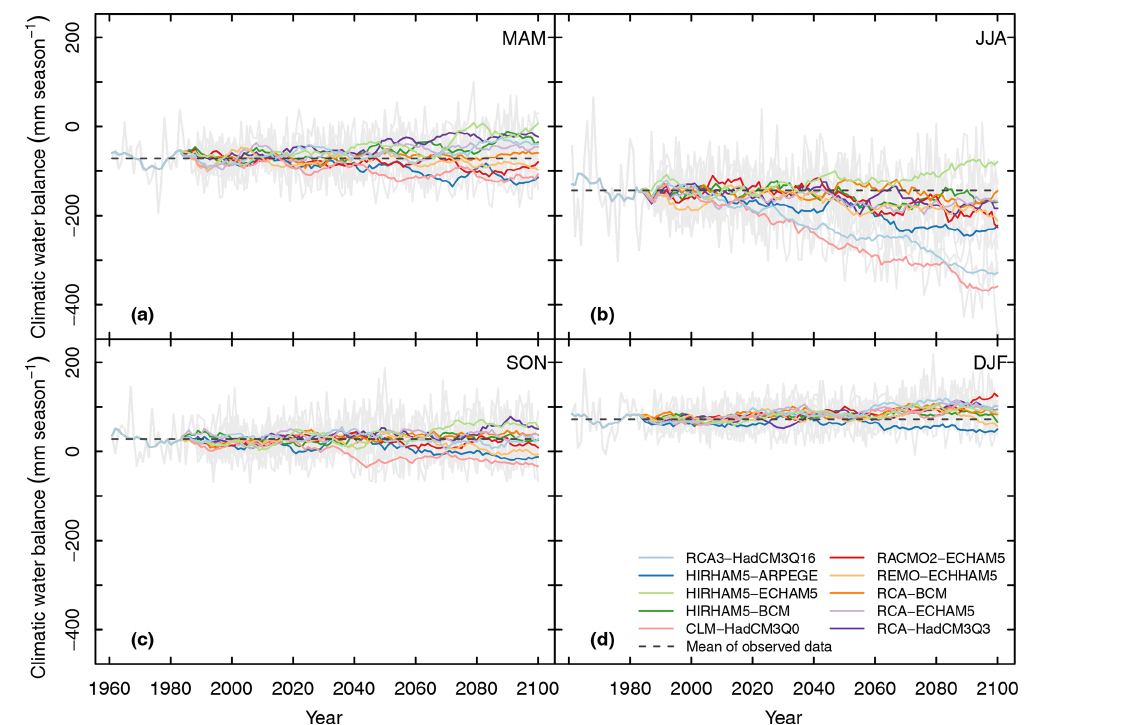
Figure 9. Seasonal climatic water balance simulated with 10 climate models for the station Geisenheim (Rheingau), Germany, for the emission scenario RCP8.5. Grey lines show the range of annual values of all models, coloured lines 11-year running means for individual model runs. The period from 1961–1988 represents observed data and the dashed baselines illustrate their mean values. (a) MAM, spring, March, April, May; (b) JJA, summer, June, July, August; (c) SON, autumn, September, October, November; (d) DJF, winter, December, January,